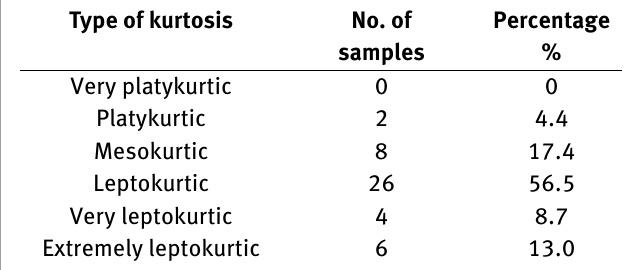
Table 7: Kurtosis of sediment samples from the bed of River Tigris within